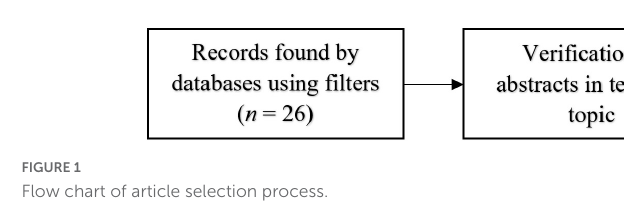
FIGURE1 Flow chart of article selection